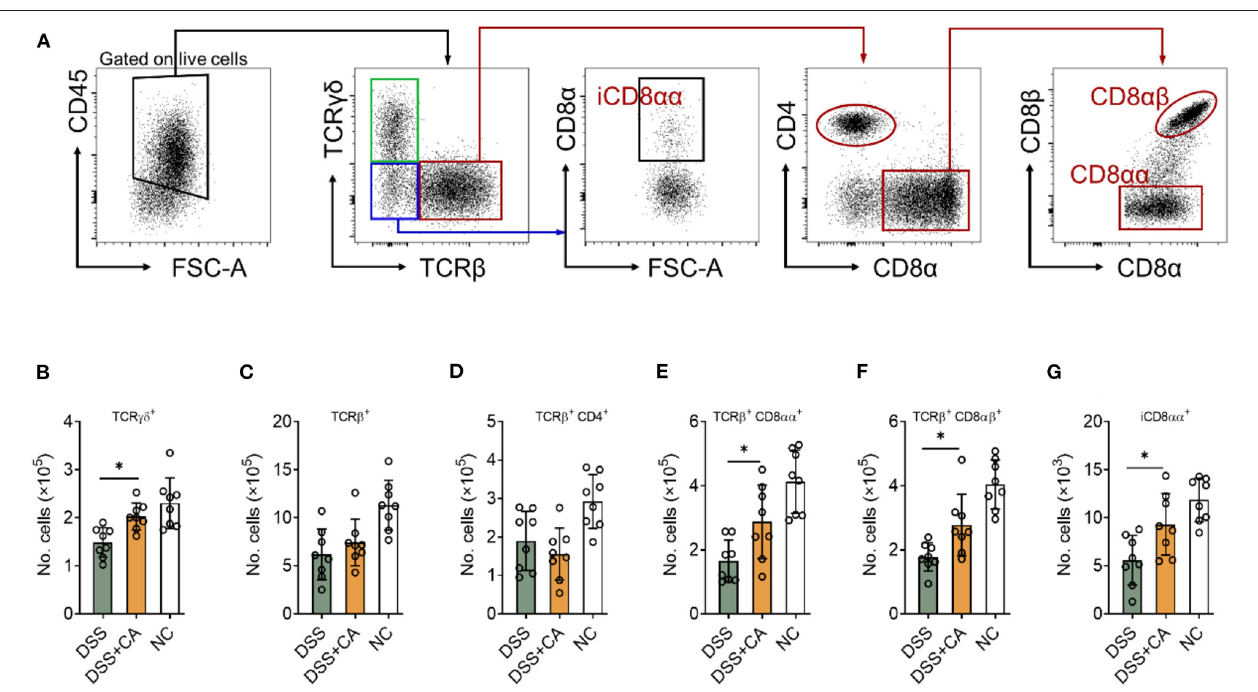
FIGURE 5 | CA restores intestinal intraepithelial lymphocyte (IEL) homeostasis during DSS-induced colitis. Colitis was induced as described in Figure 1 and IEL were isolated on day 10. Flow cytometry was performed to determine IEL subpopulations. (A) Gating strategy. (B–G) Quantification of (B) TCR γδ + , (C) TCR β + , (D) TCR β